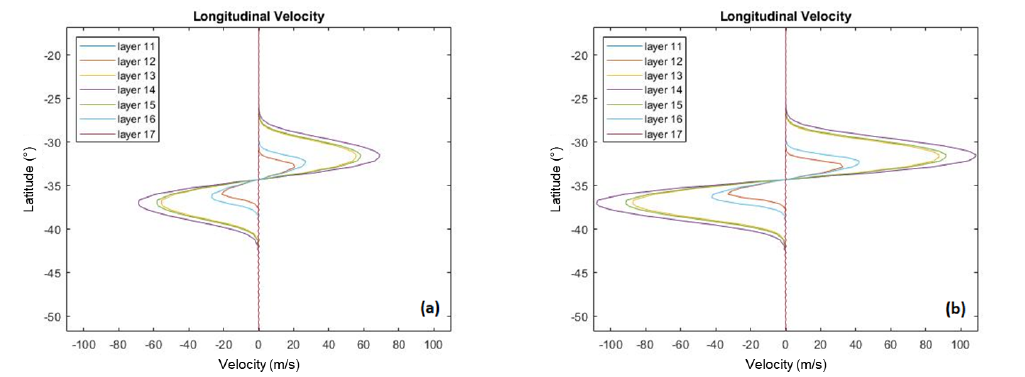
Figure 3. Relative vortex velocities along the minor axes of initial vortices for layers 11–17: ( a ) Spot 1 (strength 70 m/s) and ( b ) Spot 3 (strength 110 m/s). Layers 12 and 16 effectively define the top and bottom of the vortex as layers 11 and 17 have essentially zero relative